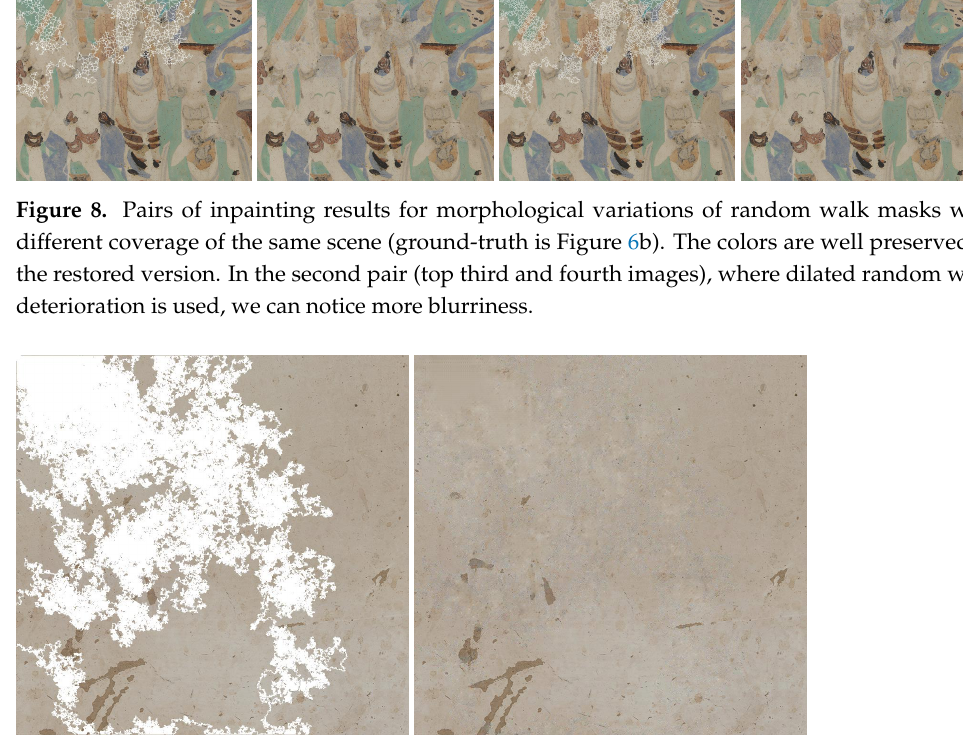
Figure 9. Inpainting result for Figure 6c. The restoration does not disrupt the color homogeneity with respect to the non-corrupted part of the